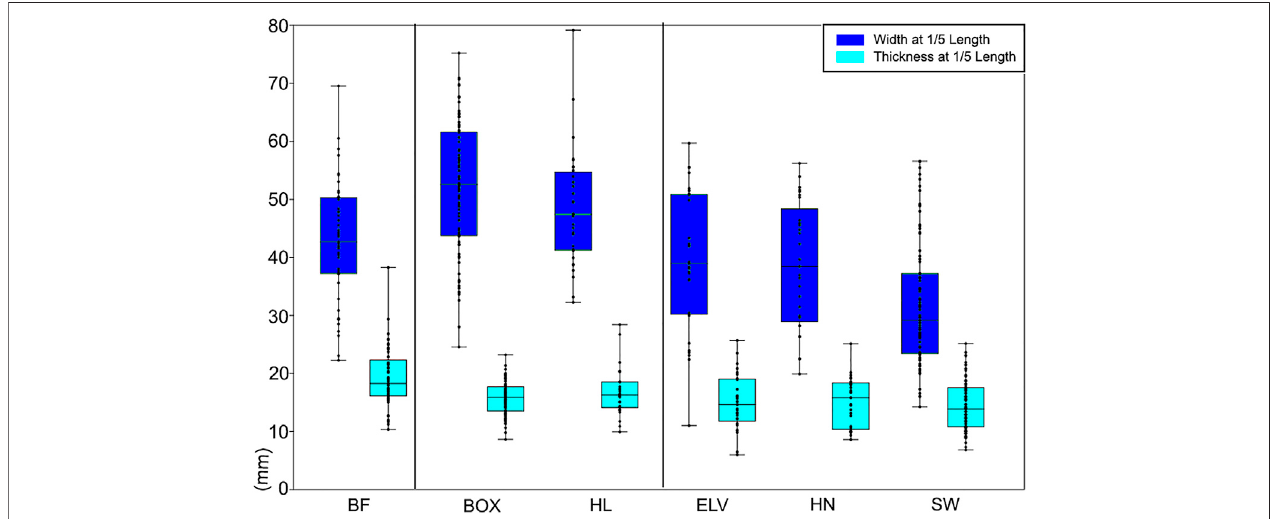
FIGURE 9 | Boxplot with jitter of Tip width and thickness. Abbreviations: BF, Brandon Fields; BOX, Boxgrove; HL, High Lodge; ELV, Elveden; HN; Hitchin, SW, Swanscombe.